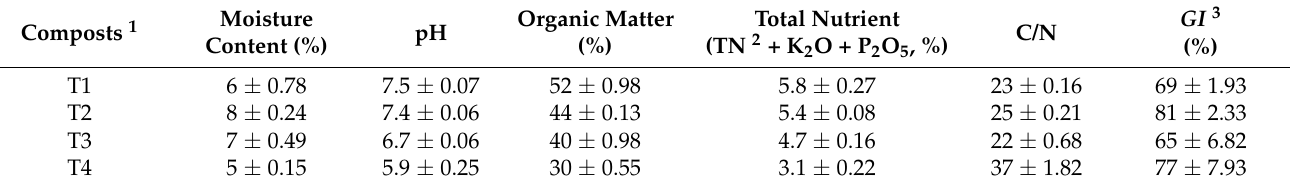
Table 2. Characteristics of different